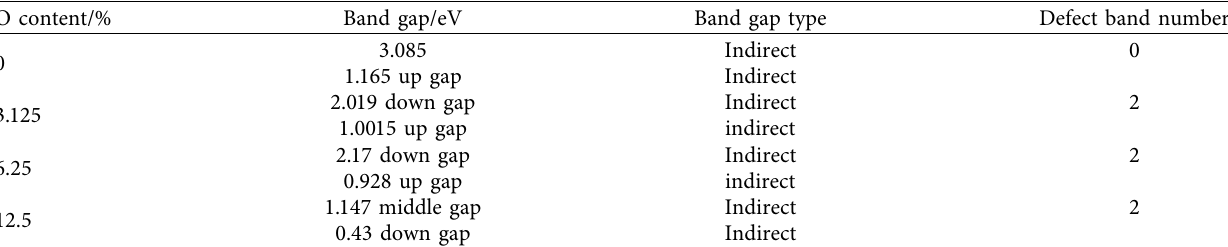
Figure 10: Band structure near the Fermi level for anatase TiO 2 with oxygen defect contents of 0% (a), 3.125% (b), 6.25% (c), and 12.5% (d). Table 5: Band gaps, band gap type, and the number of defect band for anatase TiO 2